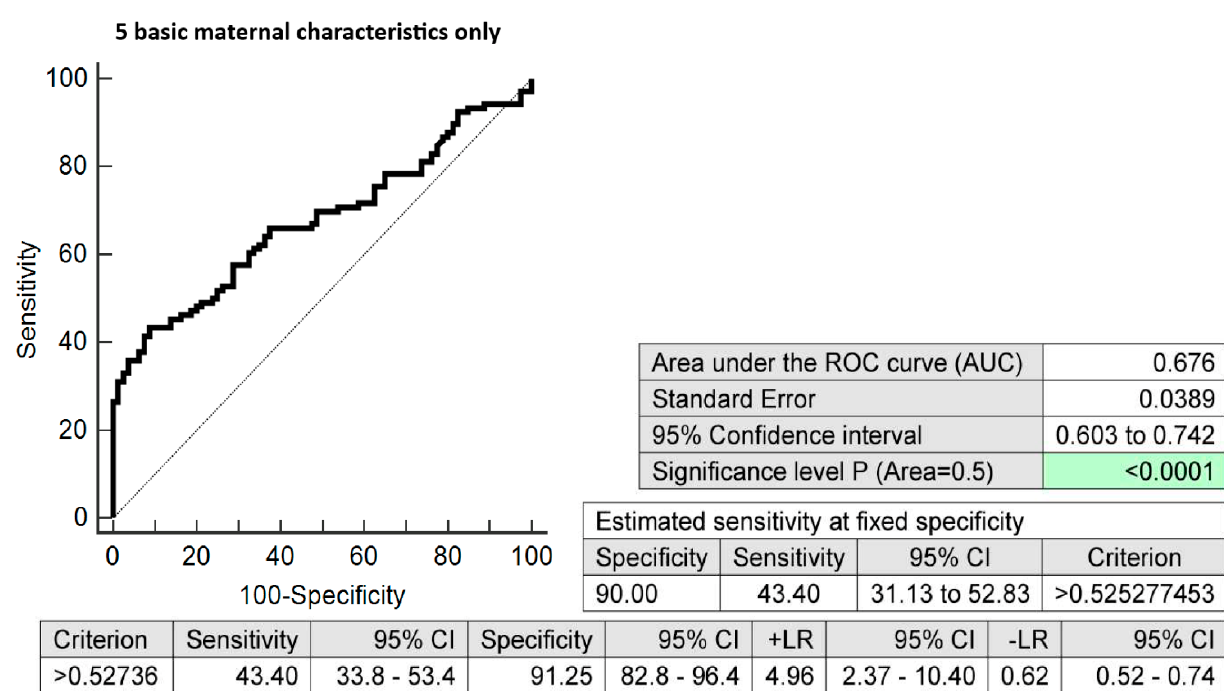
clinical characteristics (age and body mass index values at first trimester of gestation, treatment of